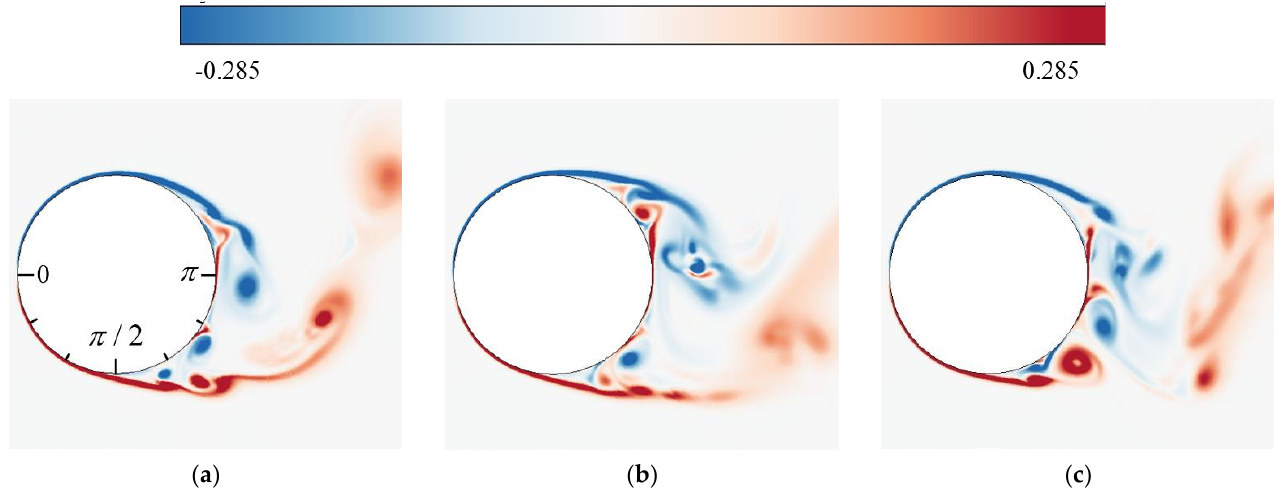
Figure 3. Vorticity distributions in the wake: ( a ) Noncavitation; ( b ) SS model ( σ = 2.92); ( c ) ZGB model ( σ = 2.92).